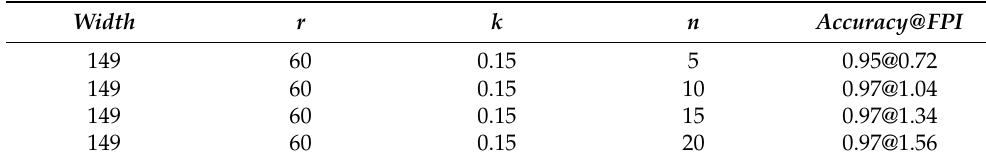
Table 10. Performance of the proposed GFNet framework on INbreast without false positive reduction but with